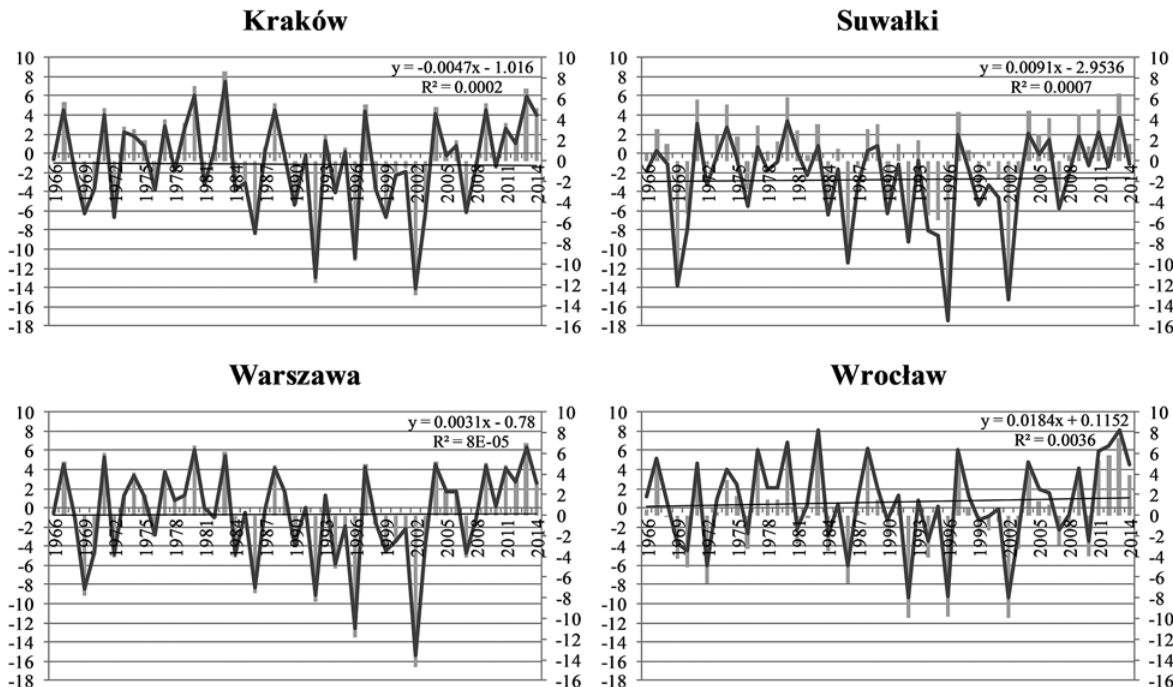
Fig. 5. Mean air temperature (°c) (line) in the christmas period and air temperature anomalies (°c) from the mean air temperature in 1966–2014 christmas period (columns) in selected stations.